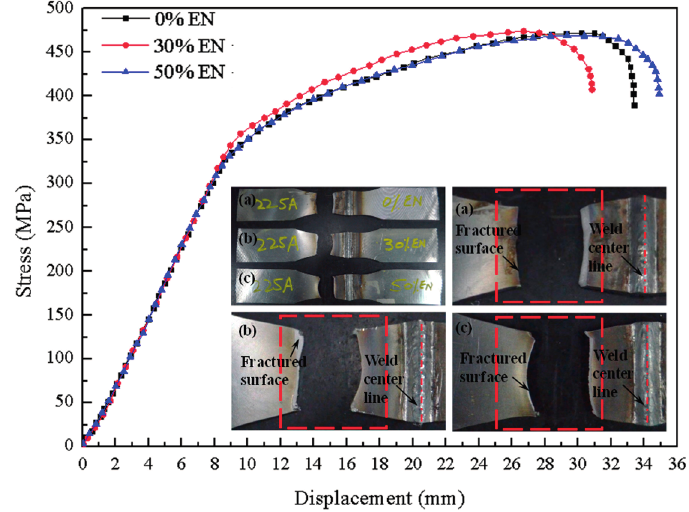
Figure 15. Stress vs. displacement at Ia of 225 A. The inset shows the fractured surfaces of the tested samples.